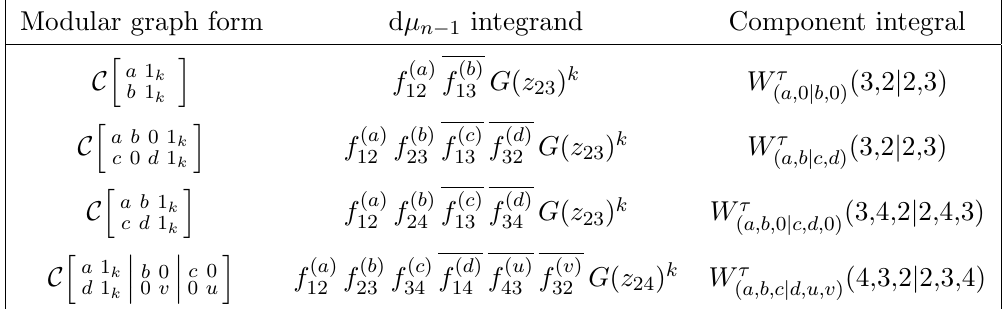
Table 1 . Component integrals giving rise to di(cid:11)erent modular graph